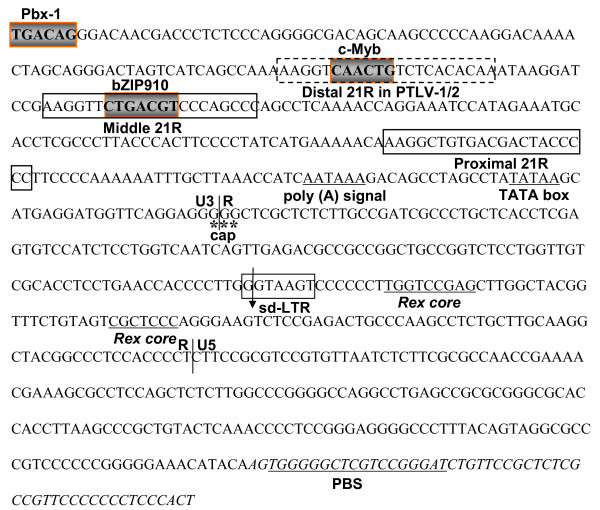
Nucleotide sequence of the HTLV-4(1863LE) LTR and pre-gag region. The U3-R-U5 locations (vertical lines), the pre-B cell leukemia (Pbx-1, TGACAG) and c-Myb (YAACKG) transcription factor binding sites, approximate cap site (cap), polyadenylation (poly(A)) signal, TATA box, predicted splice donor site (sd-LTR), and two 21-bp repeat elements (middle and proximal based on positions in HTLV-1 and -2), as well as the location of the distal 21-bp repeat in HTLV-1 and -2 (dashed lines), are indicated. In the R and U5 regions, the predicted Rex core elements and nuclear riboprotein A1 binding sites are underlined. The pre-gag region and primer binding site (PBS, underlined) are in italics.